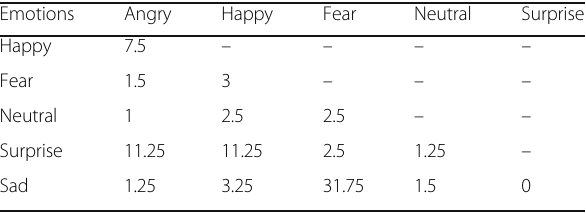
Table 2 Confusion degree of six emotions (%)